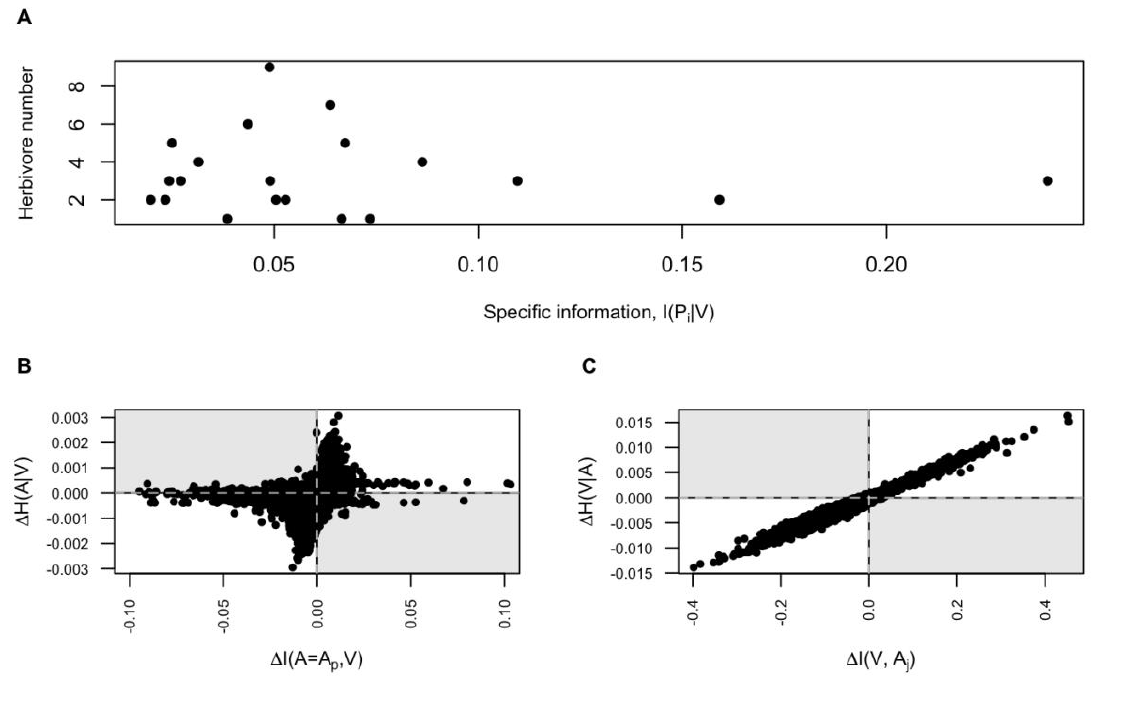
|𝑉) and the number of herbivores Fig. 1 (A) Relationship between the specific information 𝐼(𝑃 𝑖 associated with each plant species (𝐹(1,18) = 0.162, 𝑝 = 0.69, 𝑅 2 = 0.009) . (B) Relationship , 𝑉) and the community between the fitness of the mutated plant species, calculated as 1 − 𝐼(𝐴 𝑝 , 𝑉) is calculated as the weighted average of the specific conditional entropy H(A|V), where 𝐼(𝐴 𝑝 information, 𝐼(𝐴 = 𝑎, 𝑉) (Equation 3), for the set of herbivores that interact with plant p ( 𝑝 = < 0.001, 𝑅 2 = 0.27) . (C) Relationship between the fitness of the mutated herbivore species, calculated as 𝐼(𝐴 , 𝑉) , and the community conditional entropy H(V|A), where 𝐼(𝐴 = 𝑎 , 𝑉) is the specific information 𝑗 𝑗 of the mutated herbivore species with respect to VOCs ( 𝑝 < 0.001, 𝑅 2 = 0.96) . (The shaded quadrants in B and C indicate areas where the “community fitness” and the species -level fitness are of opposite sign, indicating that a mutation would be fixed in one model and eliminated in the